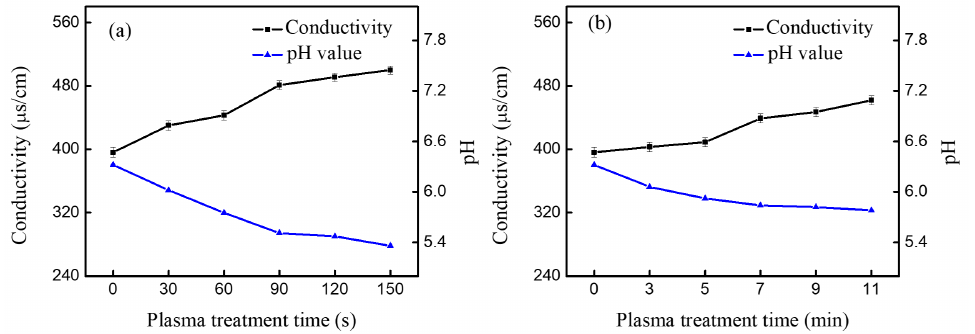
Figure 11. The conductivity and pH value of the mixture solution after plasma reaction: ( a ) A-Jet for 90 s (voltage: 6.4 kV, frequency: 90 kHz) and ( b ) P-Jet for 7 min (voltage: 8 kV, frequency: 8 kHz).